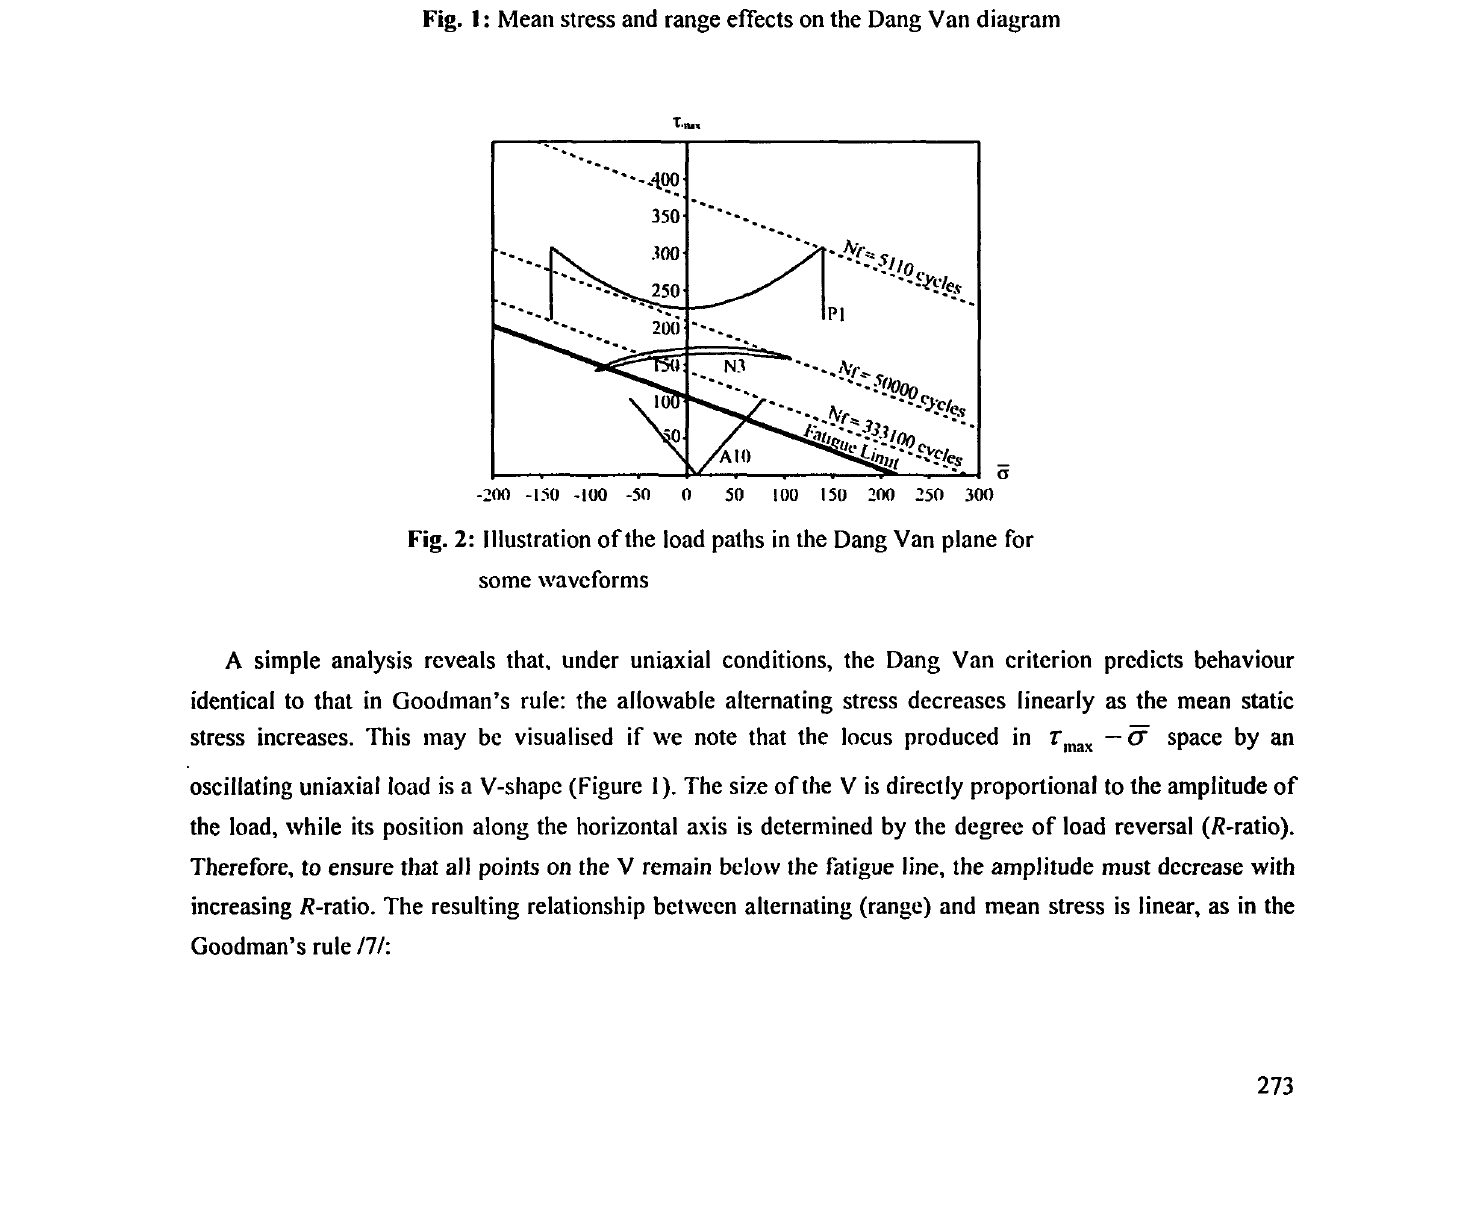
Fig. 1: Mean stress and range effects on the Dang Van diagram